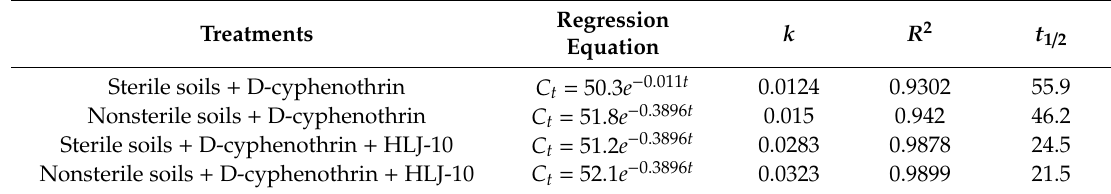
Table 6. Kinetic parameters of D-cyphenothrin degradation with Staphylococcus succinus HLJ-10 in sterile and nonsterile soils. Treatments